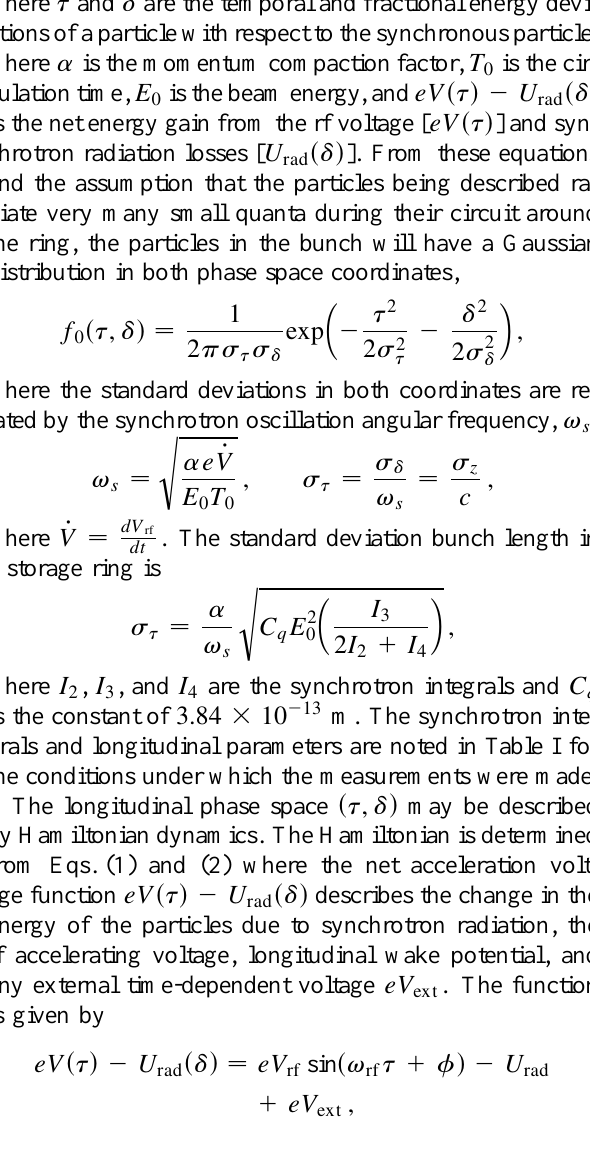
TABLE I. The synchrotron integral and longitudinal parame- ters for